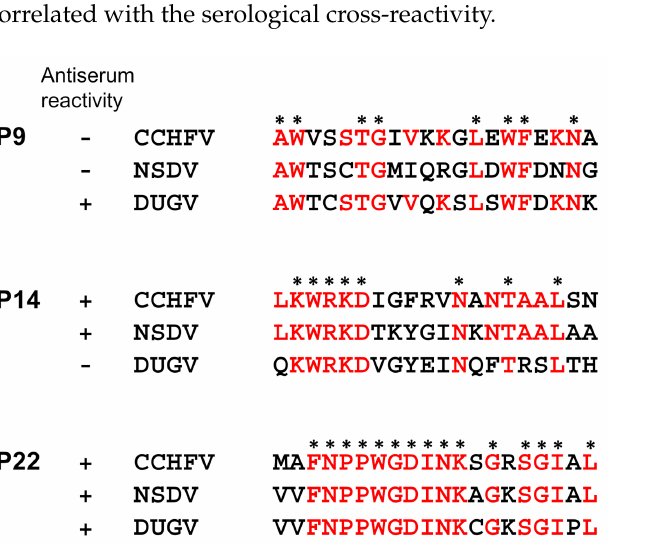
Figure 4. Amino acid sequence comparison among CCFHV, NSDV, and DUGV NPs. Amino acid sequences of CCHFV, NSDV, and DUGV NPs corresponding to the P9, P14, and P22 peptides are shown. Amino acid residues conserved among all three viruses are indicated with asterisks. Amino acid residues shared between CCHFV and DUGV NPs, between CCHFV and NSDV NPs, and among all these NPs are shown in red for P9, P14, and P22,